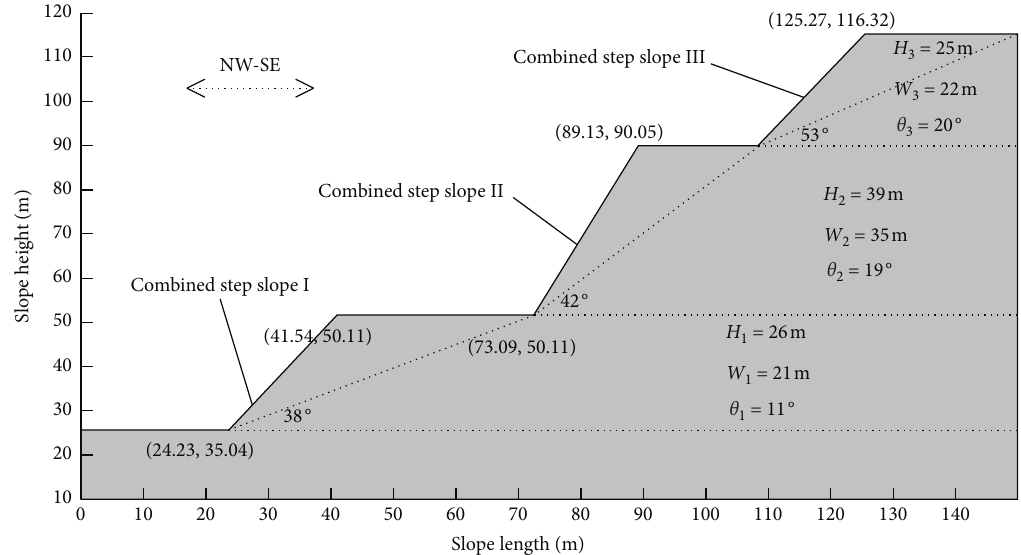
Figure 5: Study case mine rock slope with constituent elements and calculation